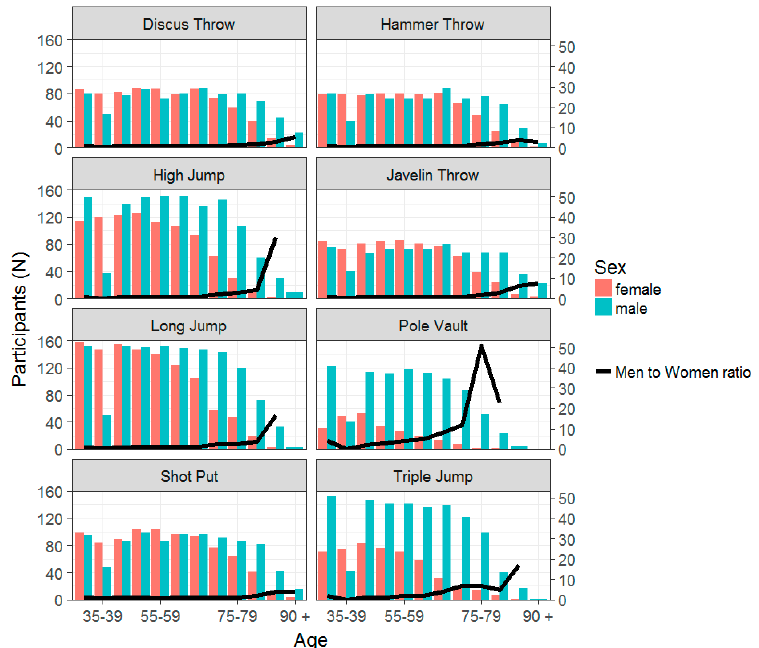
Figure 1. Participation in throwing and jumping events by sex and calendar year.